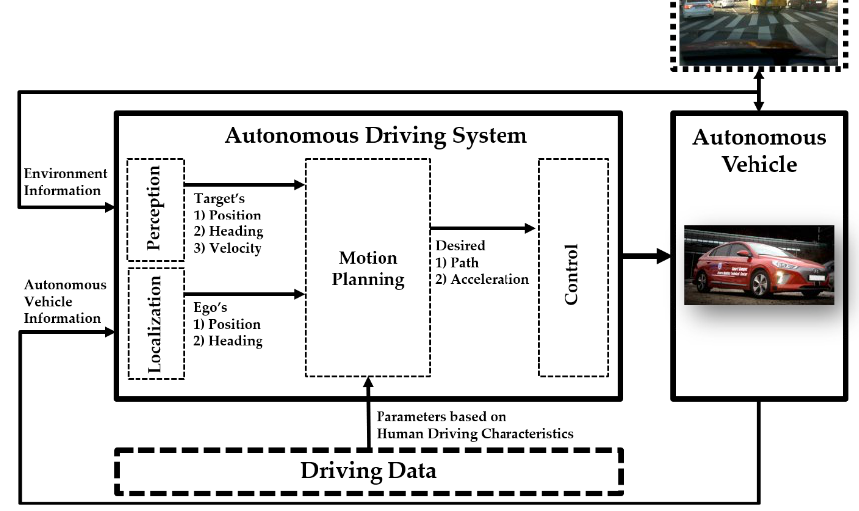
Figure 1. Overall architecture of the autonomous driving system.